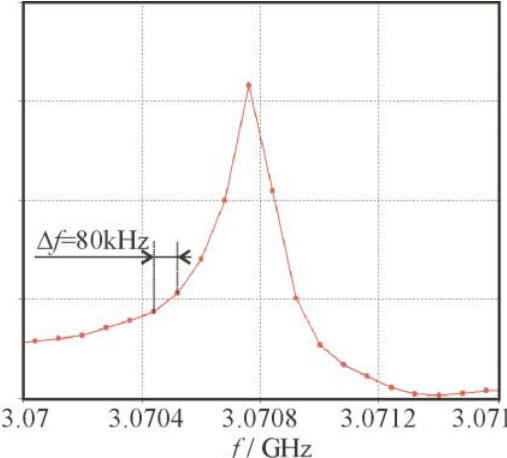
FIG. 9. (Color) DFT spectrum of the time domain analysis of the three-cell cavity. After about 2 3 10 6 time steps the spectral resolution is about 80 kHz.